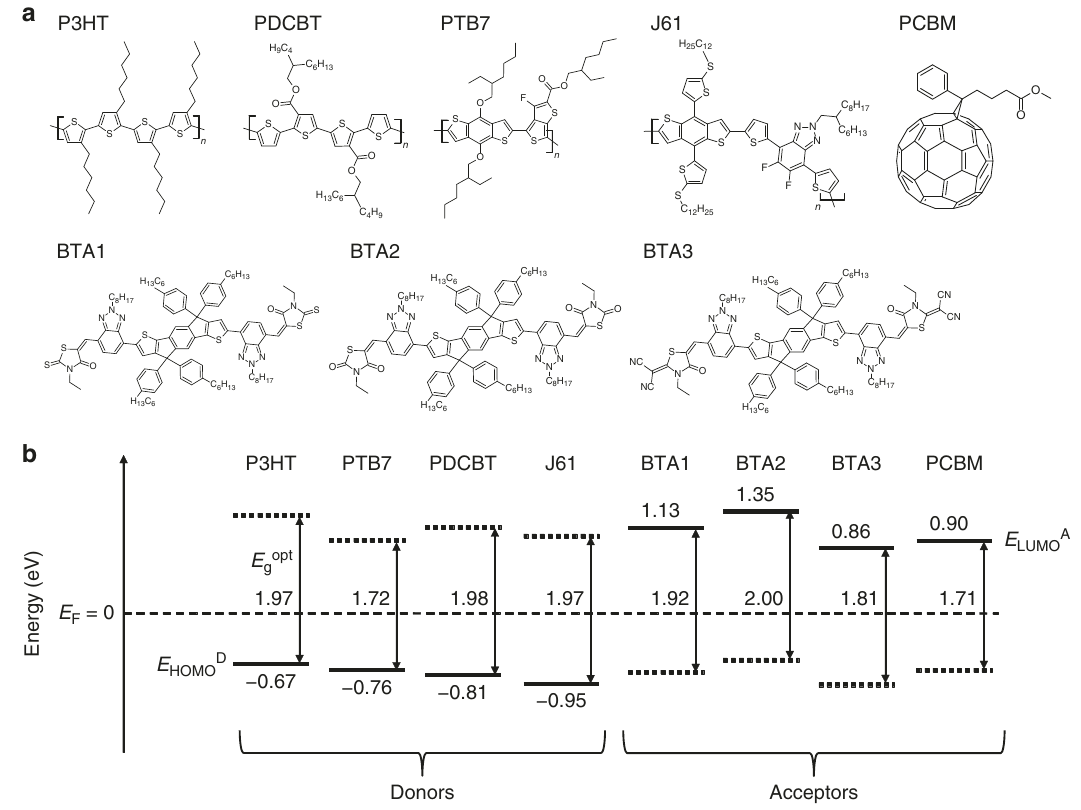
Fig. 2 Materials and energy levels. a Molecular structures of the materials used in this study. b Schematics of the energy levels of the materials with respect to the aligned Fermi level ( E F = 0). Solid lines indicate the energy of the HOMO onset for the donor ( E HOMO D ) and LUMO onset for the acceptor ( E LUMO A ), evaluated by UPS and LEIPS, respectively. E g opt are optical band gaps determined by absorption and emission spectra. The dotted lines indicate E HOMO D + E opt and E A − E opt for the donors and the acceptors, g LUMO g